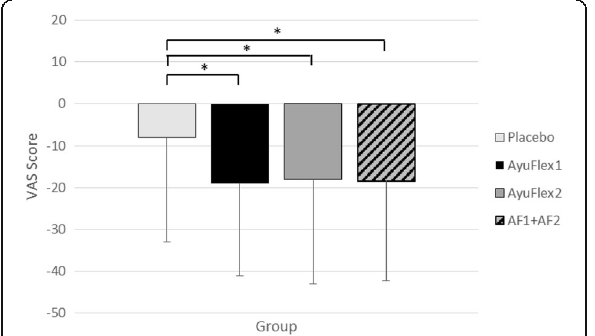
Fig. 9 Mean ± SD changes in knee pain following leg extension exercise. Significant differences were noted between the AyuFlex 1 ( p = 0.022), AyuFlex 2 ( p = 0.043), and AF1 + AF2 ( p = 0.039) vs. Placebo